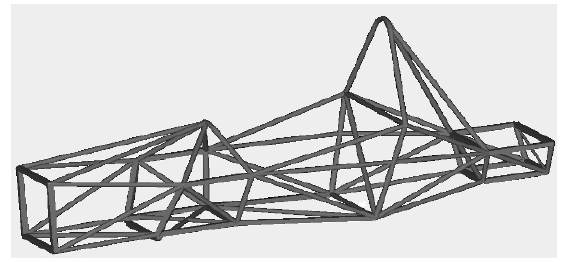
Figure 3. Simulation and observation volume.